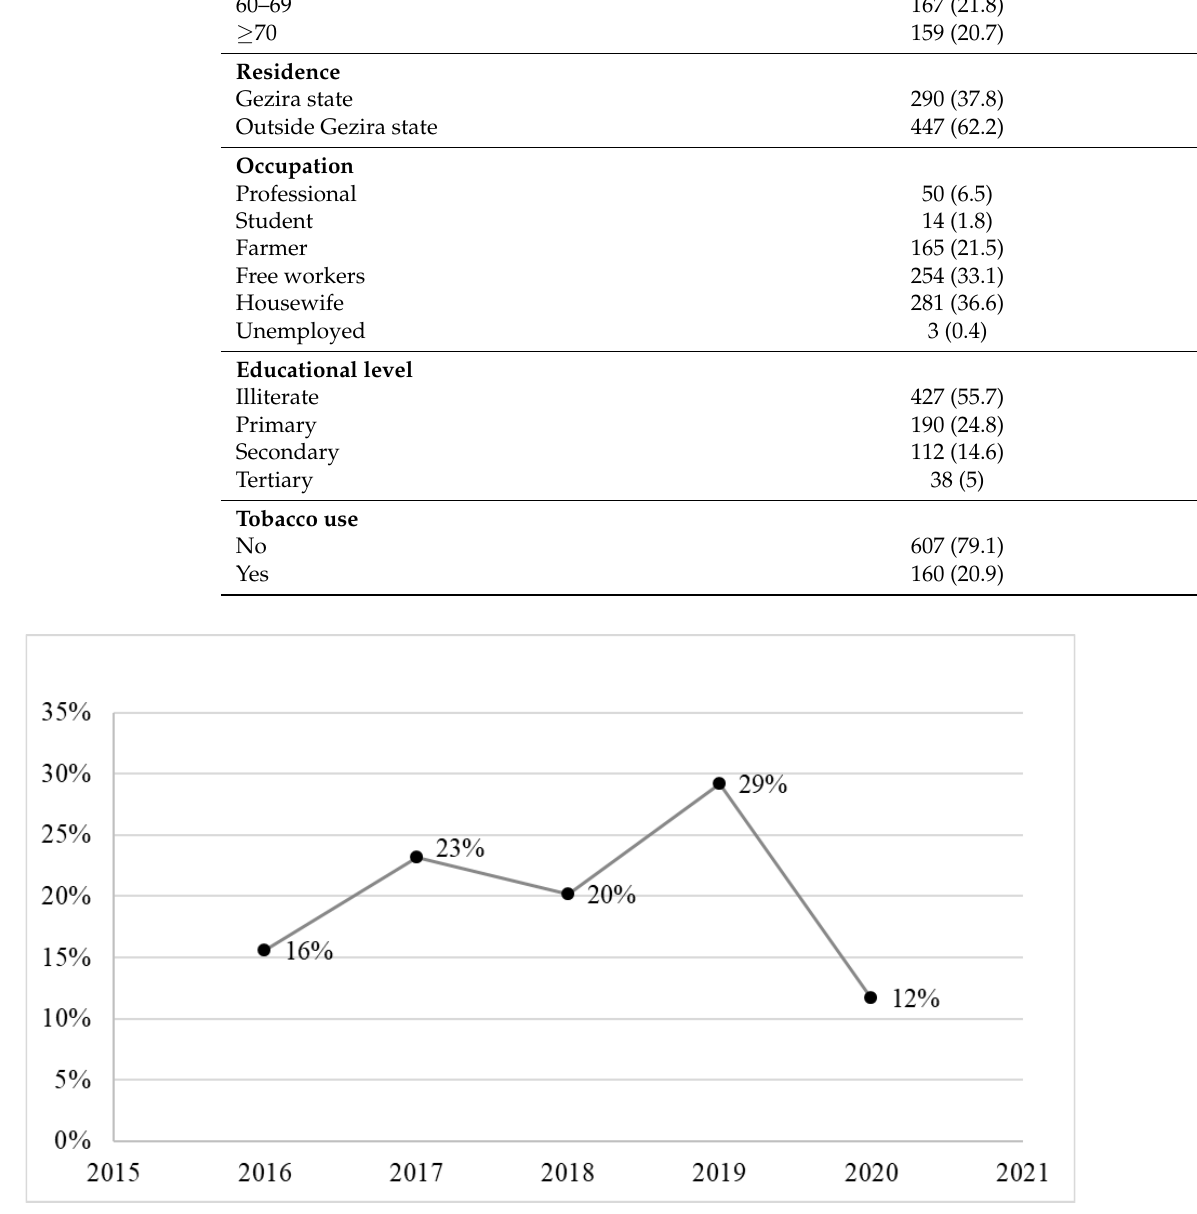
Figure 3. Proportions of HNCs out of all cancer cases from September 2016 to September 2020.